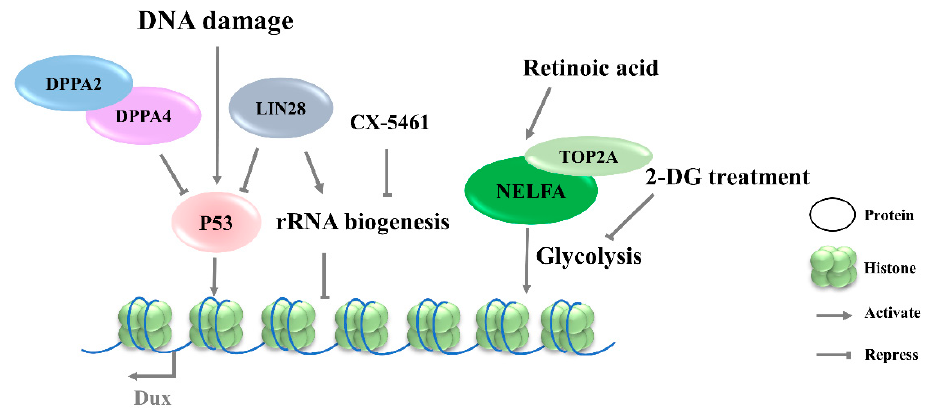
Figure 3. Signaling pathways involved in the regulation of Dux expression. DNA damage lead to P53 activation and then upregulates Dux expression. CX-5461 can decrease rRNA biogenesis and activate Dux expression. Retinoic acid participates in the NELFA-mediated Dux activation, and 2-DG inhibited glycolytic flux and activated Dux expression. DPPA2/4, developmental pluripotency associated 2/4; NELFA, negative elongation factor complex member a; TOP2A, DNA topoisomerase 2a; P53, tumor protein 53.